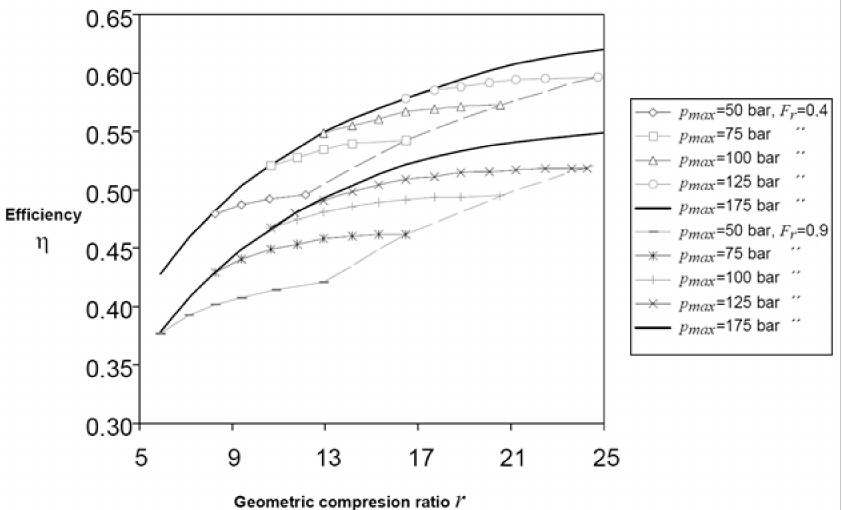
Figure 7. The efficiency of the Dual Miller cycle vs. compression ratio for two fuel–air ratios (determining α and/or β ) and five maximum pressures. C = 1, p (cid:48) in = 2 bar, T in = 300 K, EGR = 10%, r in = 1, η com,int,v = 0.95 , J com = 0.9, r e = 0.85 r ; γ and γ b are dependent on temperature following the appendices. Both continuous lines with no markers show β = 1.0, for pressures below 175 bar (zone of intersection with symbol lines). Right side common boundary discontinuous lines show α = 1.0 and thus correspond to a pure Diesel